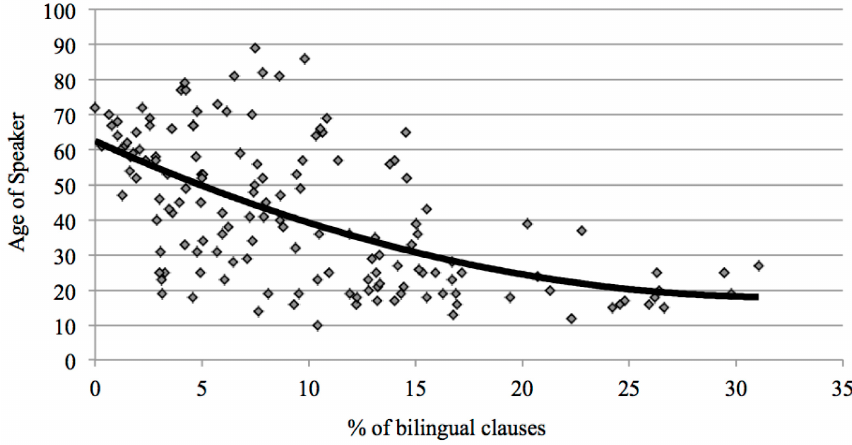
Figure 7. Percentage of bilingual clauses by speaker age.